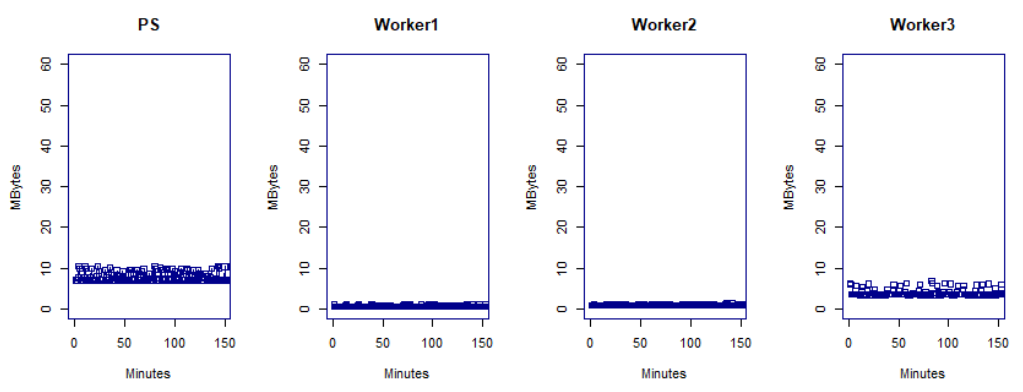
Figure 15. Incoming traffic per worker for the model parallelism scheme.